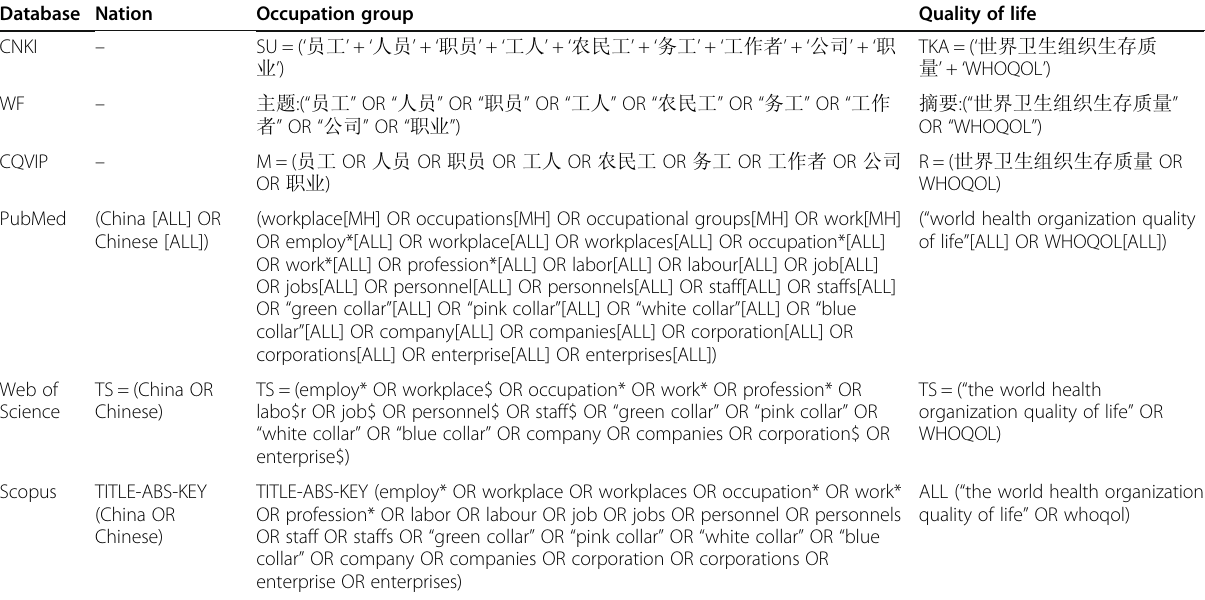
Table 1 Search strategies in CNKI, WF, CQVIP, PubMed, Web of Science and